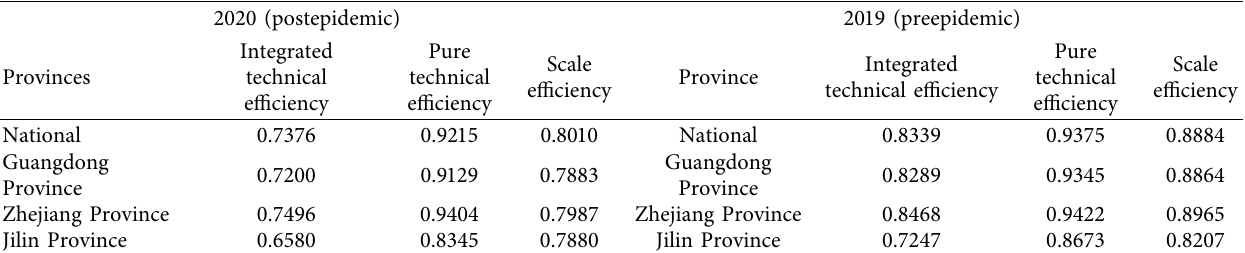
Table 3: Comparison of SME financing efficiency: public